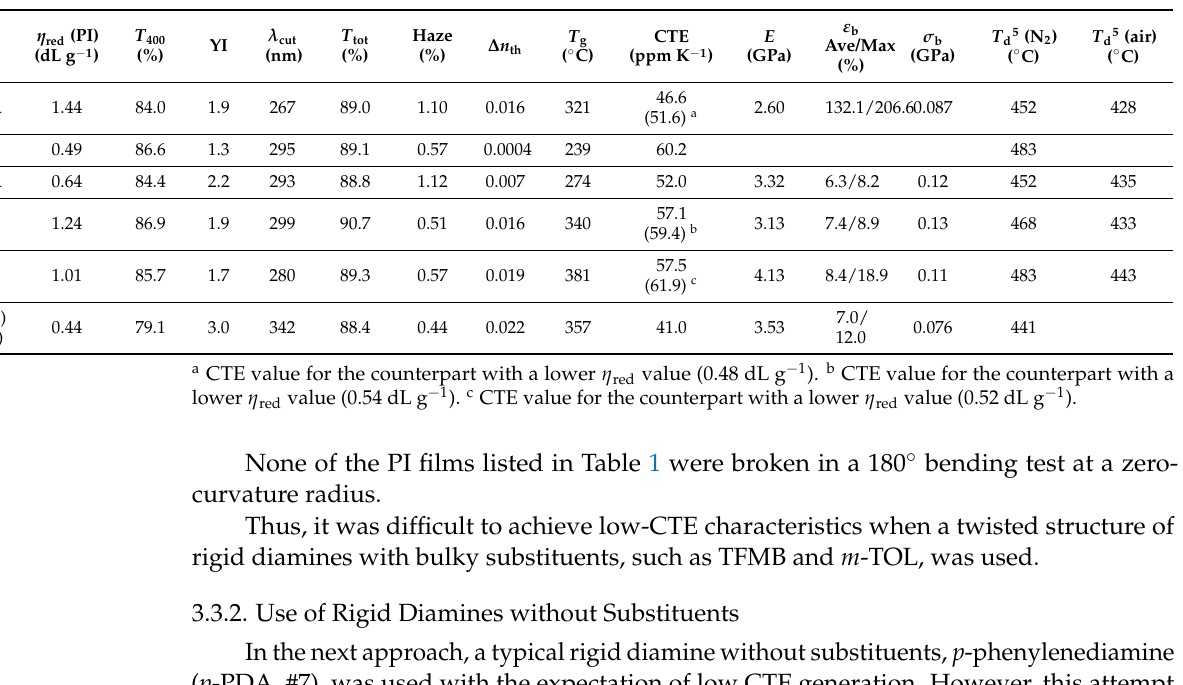
Table 1. Film properties of H-PMDA-based PIs obtained using common